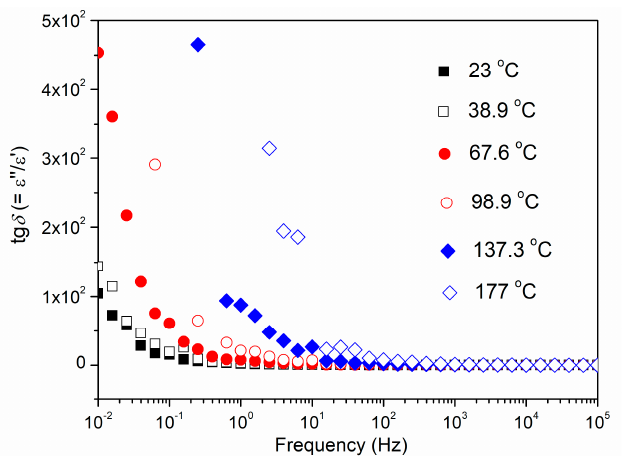
Figure 10. Frequency − dependent dielectric loss (tg δ ) of the CCTO ceramic at different temperatures. The relative dielectric constant ε r for CCTO material was measured in cooling mode from 150 ◦ C to room temperature at a constant frequency of 1 kHz. The relative dielectric constant increases with increasing temperature from about 1460 at room temperature to 2460 at 150 ◦ C (Figure 11a). It can be seen that these measurements are in good agreement with the values obtained from the impedance measurements at the same frequency of 1 kHz (Table 5).